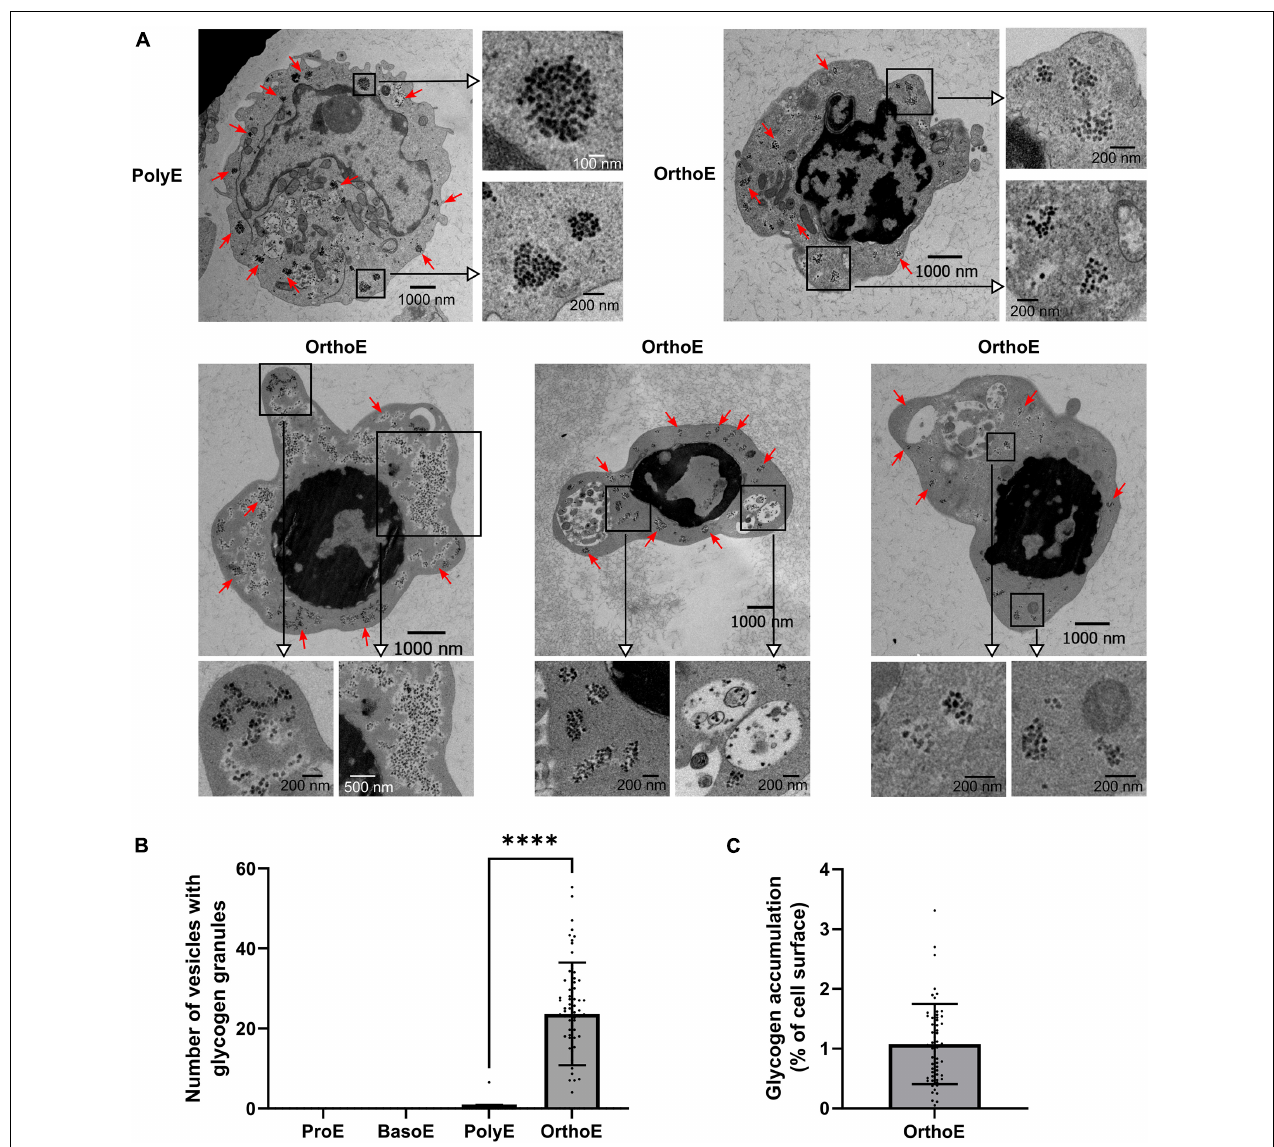
FIGURE 6 | Glycogen accumulation in OrthoE. (A) Representative images of the only ProE exhibiting glycogen granules and several OrthoE with inset on glycogen granules (red arrows). (B) Quantification of vesicles containing glycogen granules and (C) percentage of cell surface occupied by glycogen granules (surface of glycogen granules relative to cell surface × 100) in OrthoE. Kruskal–Wallis analysis on at least 20 images for the three replicates. ∗∗∗∗ p <